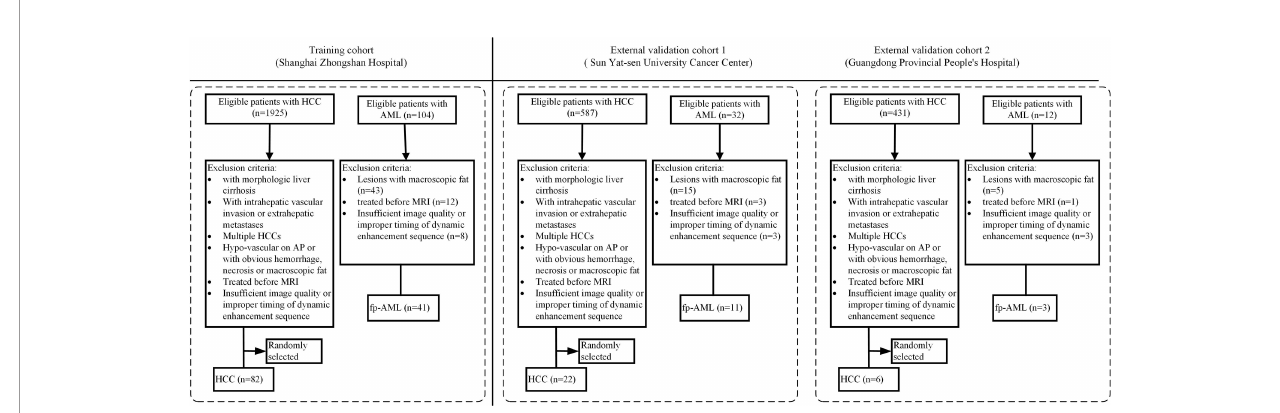
FIGURE 1 | The patient enrollment process for this